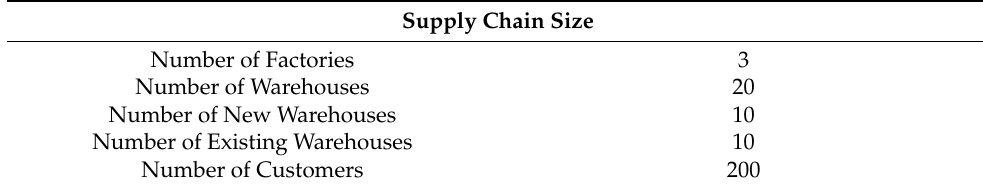
Table A1. Supply chain size.